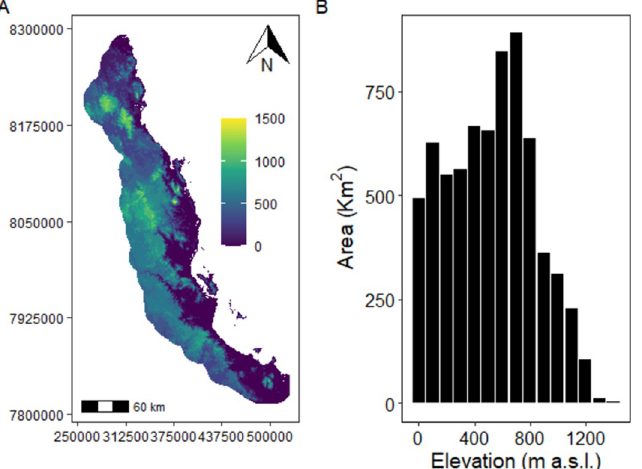
Fig 4. Elevational profile of the Wet Tropics bioregion: (a) elevation map (m a.s.l. with UTM grid coordinates) and (b) rainforest area by elevational band.